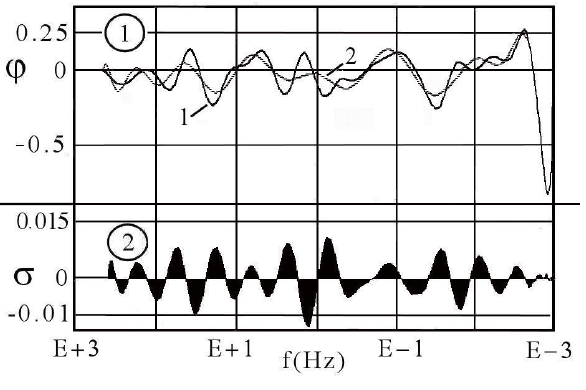
Figure 22. Fourier series polynomial. Envelope of autocorrelation function between equilibrium and reversible potential. Graph ( 1 ): autocorrelation function ϕ , 1: variation of experimental curve (full line), 2: variation of computed model (dashed line); graph ( 2 ): residual deviation σ .